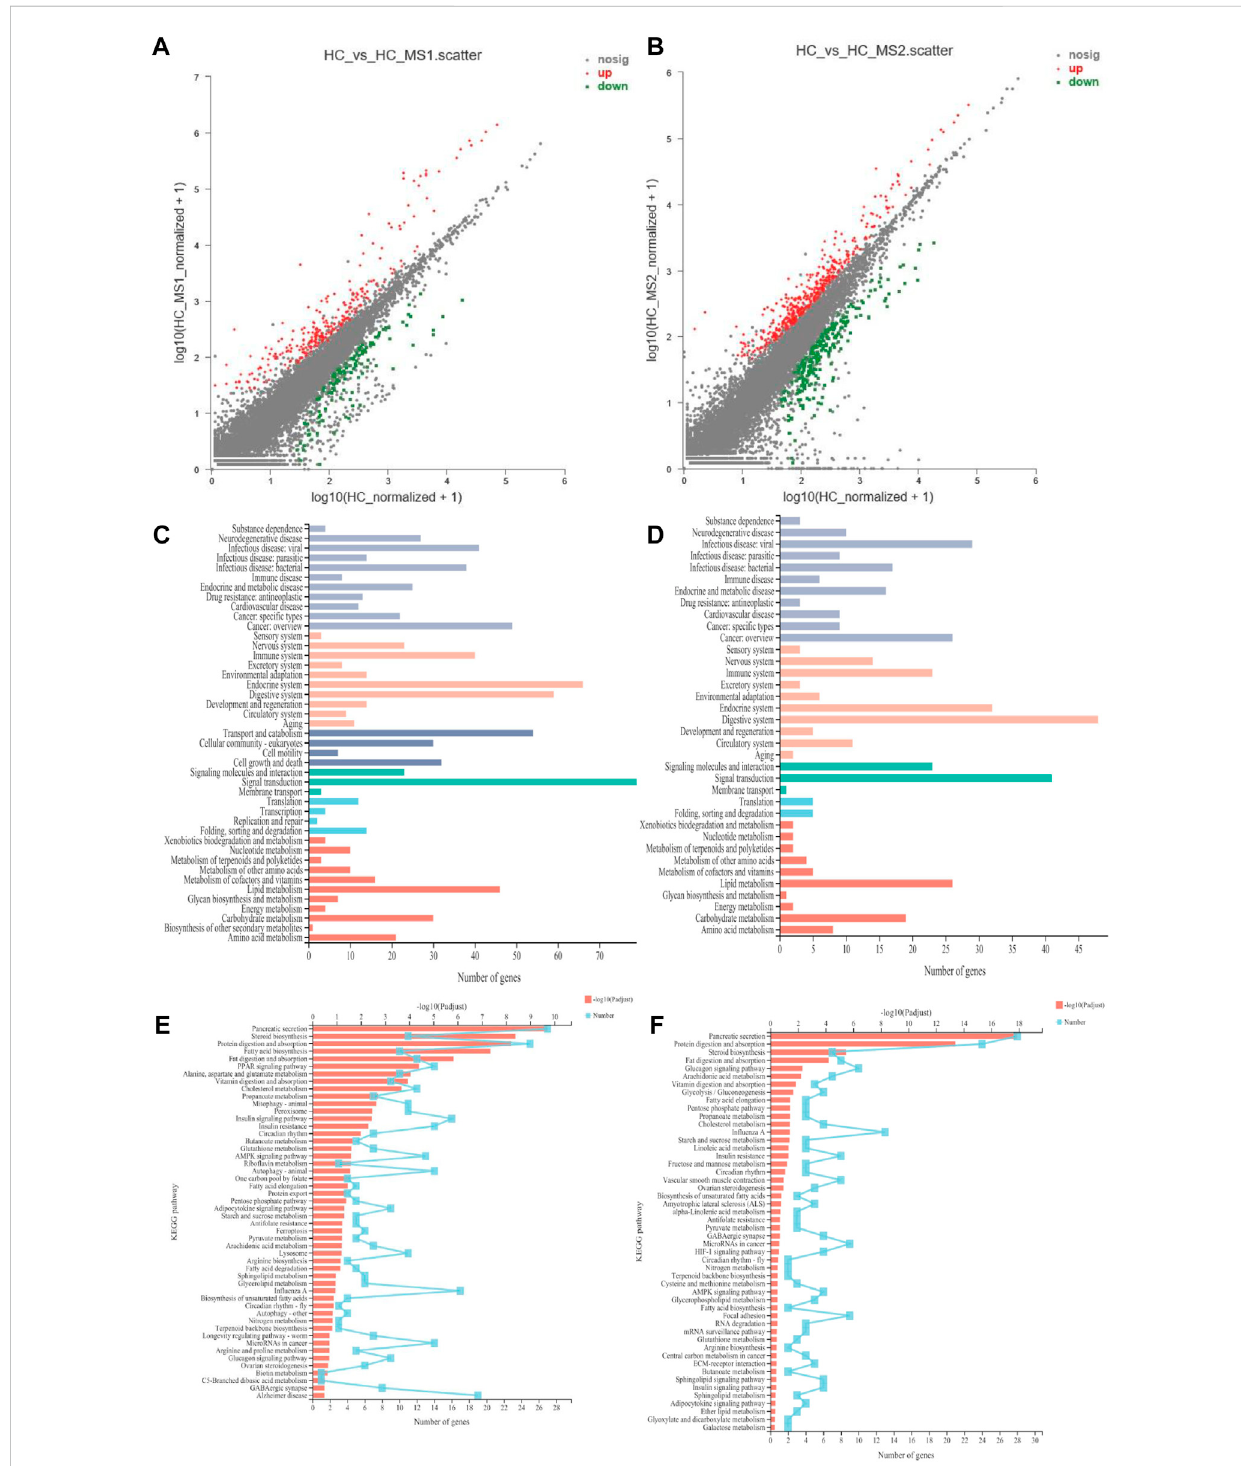
FIGURE 5 Scatter diagram of differentially expressed genes in RNA-seq (A,B) . KEGG pathway category of differentially expressed genes (C,D) . KEGG pathway enrichment in RNA-seq (E,F) (n =